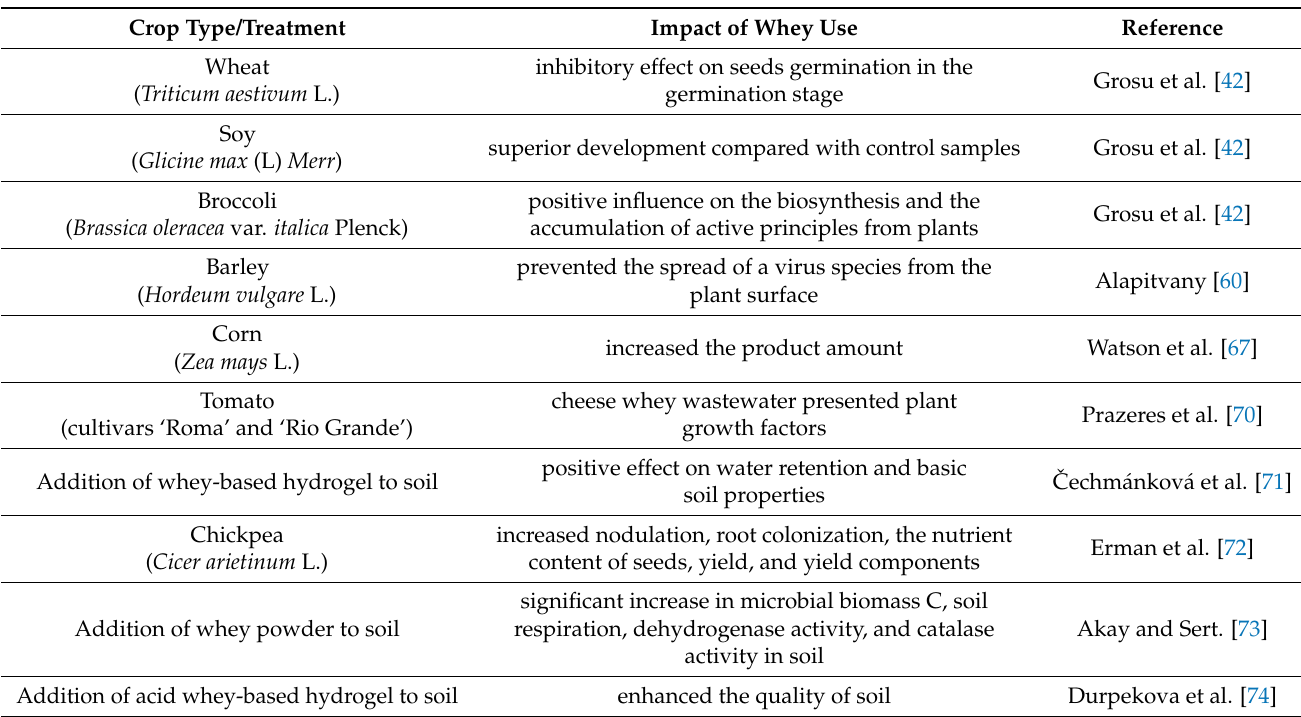
Table 4. Examples of the use of whey in different